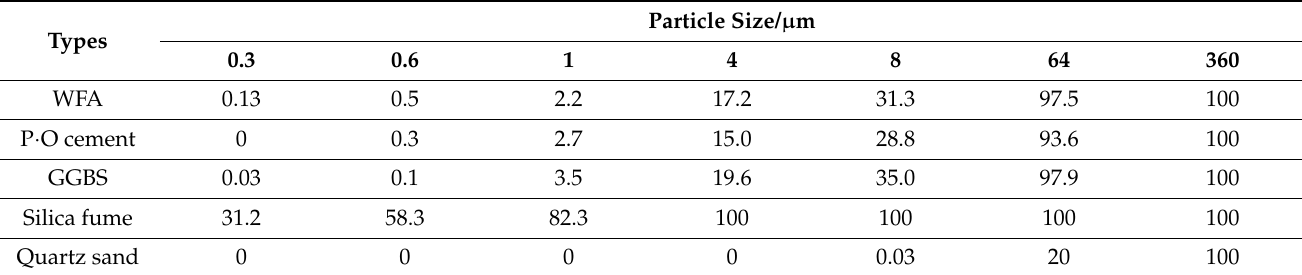
Table 3. Measured particle size distributions of the cementitious materials